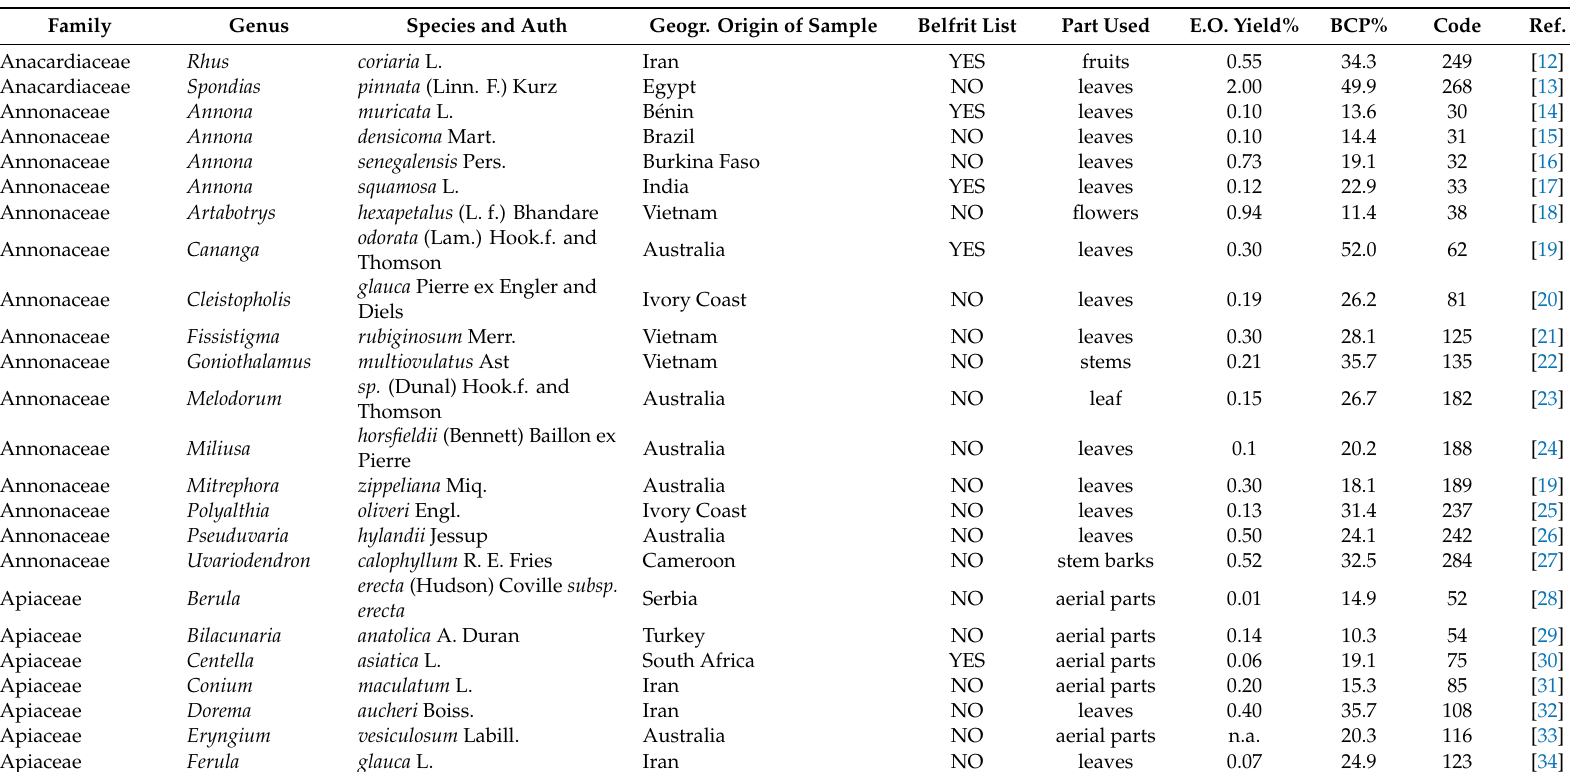
Table1. Occurrenceof( E )- β -caryophyllene(BCP)indi ff erentplantspecies. n.a., datanotavailable, theessentialoil(E.O.)yieldisexpressedasvolume /